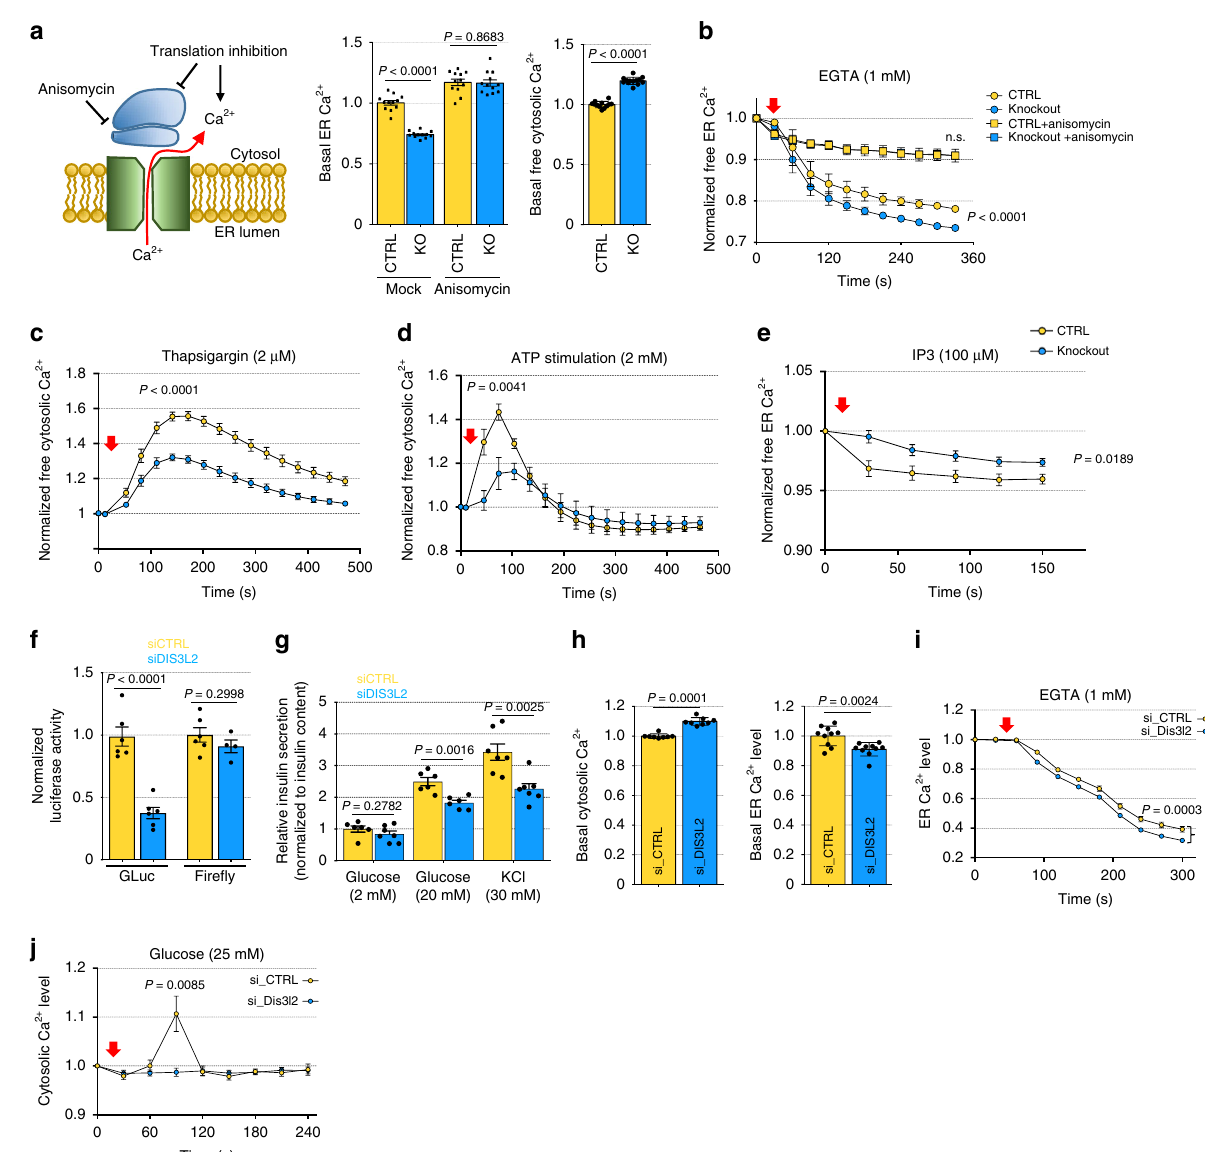
Fig. 4 Impaired intracellular calcium storage upon DIS3L2 loss. a Left panel: Schematic representation of increased ER calcium leakage through ER membrane-localized translocon (shown in green) upon translation inhibition (perhaps by DIS3L2 loss). Basal free ER (middle) and cytosolic (right) Ca 2 + levels are shown in the middle and right panels, respectively ( n = 12 independent experiments). Bars representing mean ± SEM and P values (unpaired two- tailed Student ’ s t test, 0.95 con fi dence intervals) are indicated. b – e ER calcium leakage in mESCs pretreated with or without anisomycin ( n ≥ 8). In b , note the overlapping values for control and knockout cells treated with anisomycin. Normalized free cytosolic Ca 2 + measured after treatment with thapsigargin ( c ) or ATP ( d ). e ER calcium release in mESCs upon IP3 stimulation (in b – e , n = 10 independent experiments). Red arrows indicate the time of chemical treatments. f Normalized luciferase activity of indicated reporters in Min6 cells ( n = at least four independent experiments). g Relative insulin secretion levels in Min6 cells upon glucose or potassium stimulations ( n = 6 independent experiments). h Basal free ER (left) and cytosolic (right) Ca 2 + levels in Min6 cells transiently transfected with indicated siRNAs ( n = 8 independent experiments). i ER calcium leakage in DIS3L2-depleted Min6 cells ( n = 10 independent experiments); red arrow indicates the time of EGTA treatment. j Cytosolic calcium levels upon high glucose stimulation of siDIS3L2- transfected Min6 cells ( n = 10 independent experiments); red arrow indicates the time of glucose stimulation. Bars represent mean ± SEM. P values (unpaired two-tailed Student ’ s t test, 0.95 con fi dence intervals). Source data are provided as a Source data fi